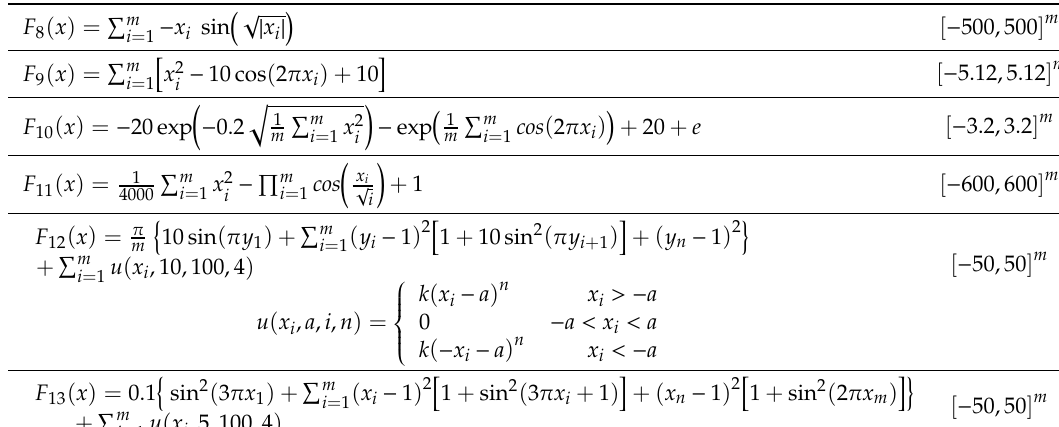
Table A2. Multimodal objective